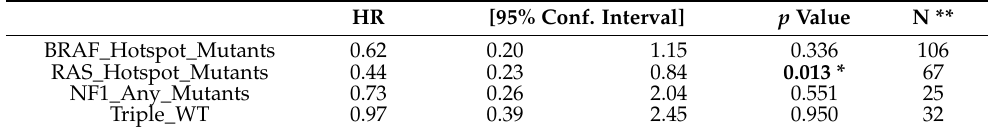
Table 7. Role of AR in overall survival in four subtypes of